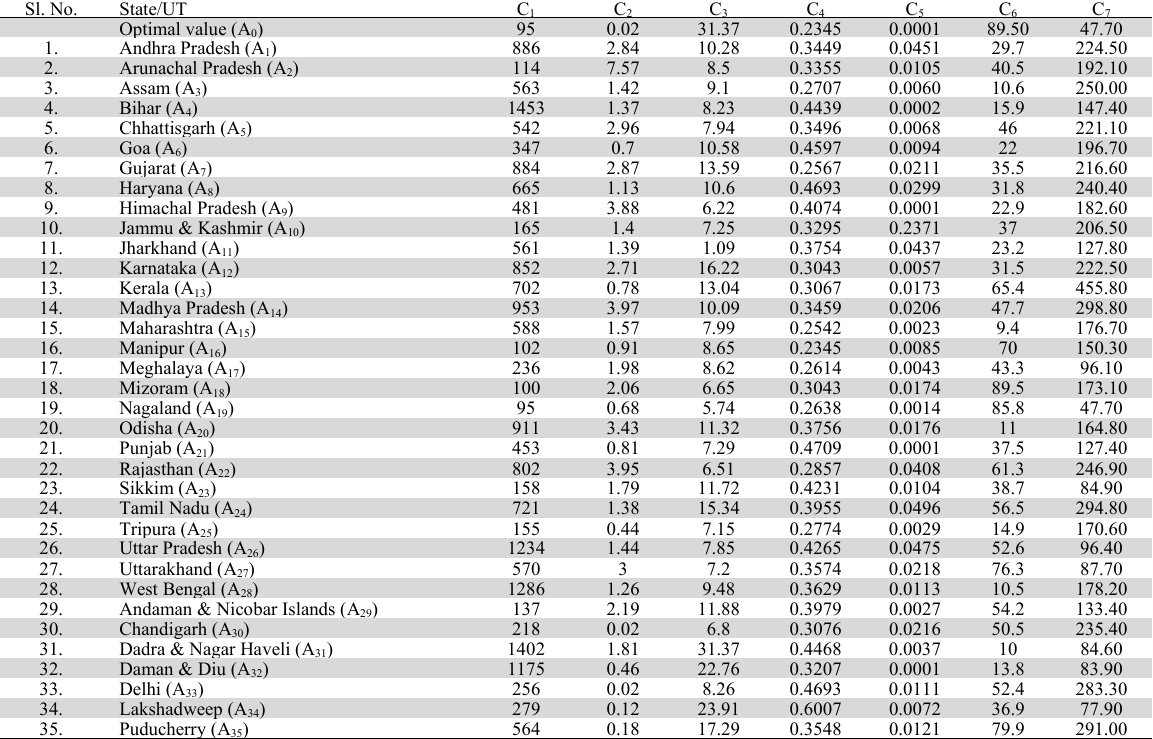
Decision matrix for the police performance appraisal problem Sl. No.